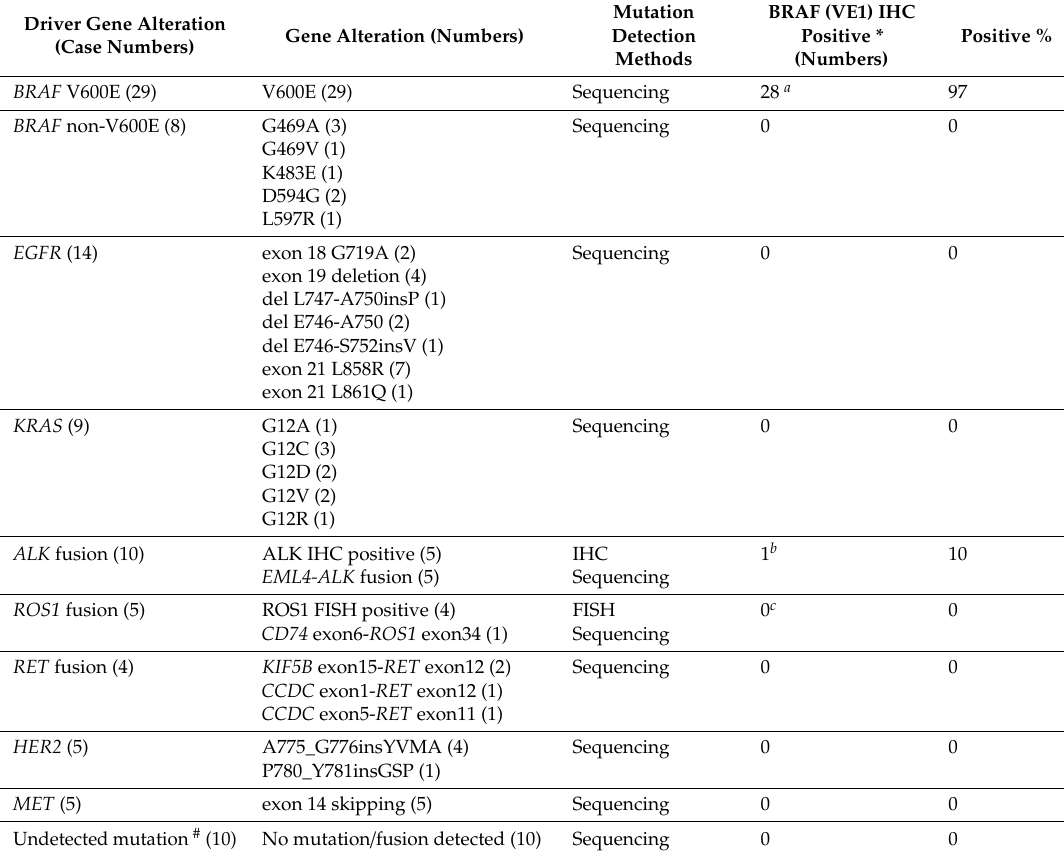
Table 3. BRAF VE1 immunohistochemical staining for BRAF V600E, BRAF non-V600E, and other major driver mutations in lung